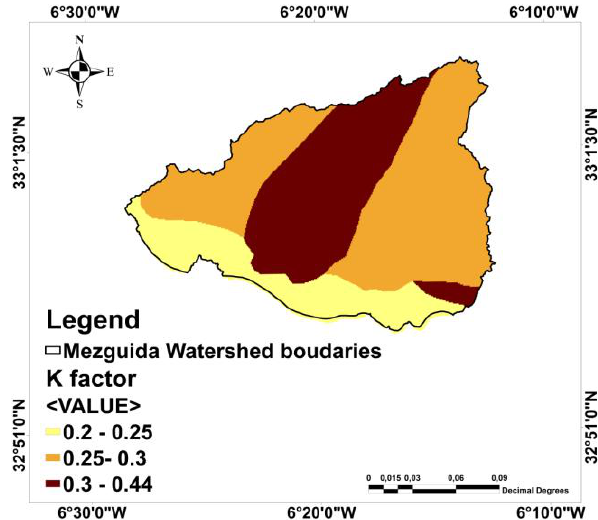
Figure 5. K factor map of Mezguida